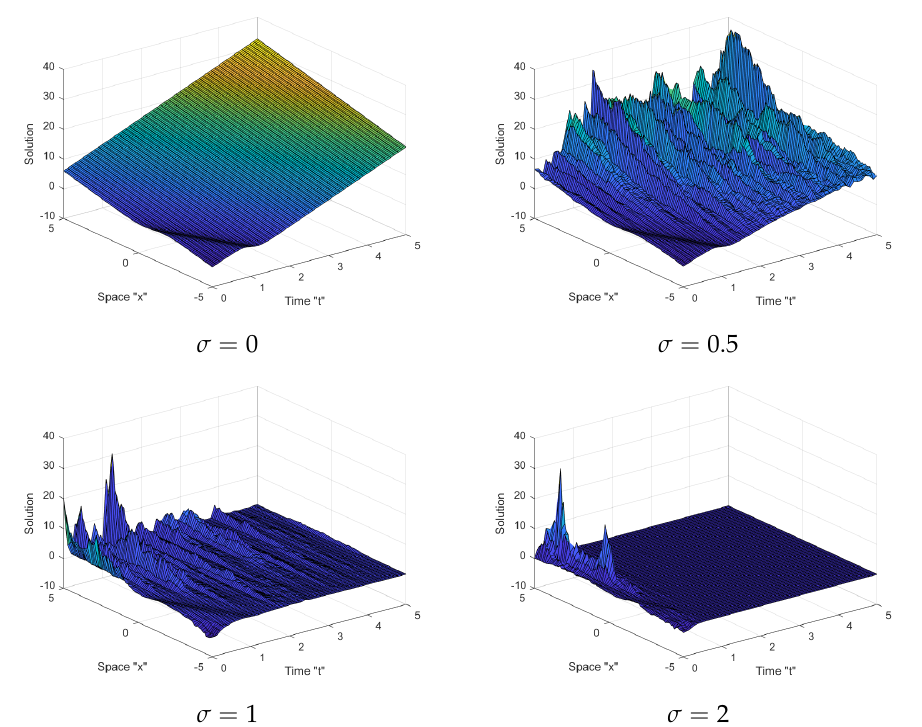
Figure 3. 3D plot of the obtained solution ϕ 2,3 ( x ,1, t ) of Equation